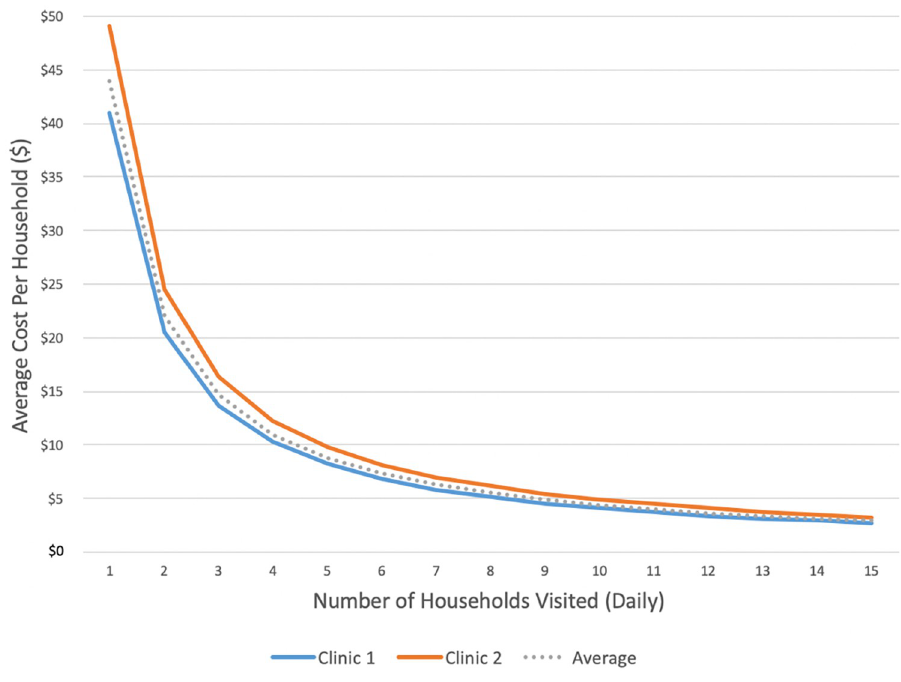
Fig 1. Average cost per household based on the number of households visited per day. Cost estimates are derived from the top-down cost estimates. As the number of households visited per days increases, the average cost per household decreases. Clinic Two has a more expensive cost per household at all values, but the difference in the cost per household between the clinics converges as the number of households visited per day